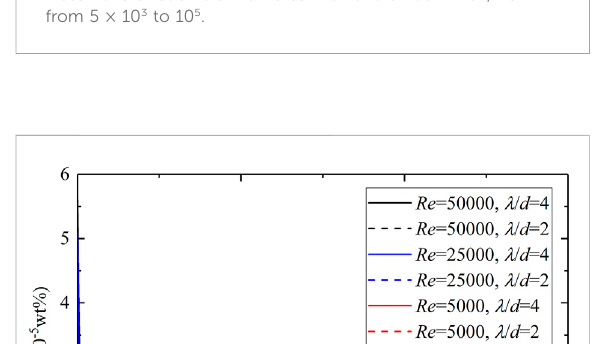
FIGURE 8 Mass transfer coef fi cient on crest wall and smooth wall, Re from 5 × 10 3 to 10 5 .